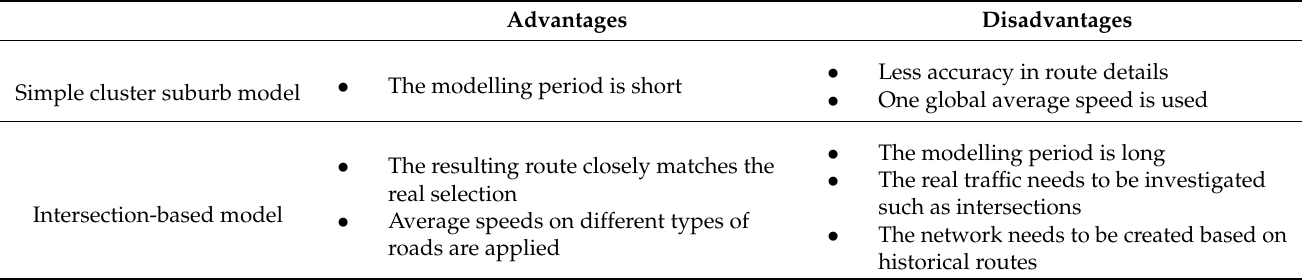
Table 8. Comparison of Simple cluster suburb model and Intersection-based